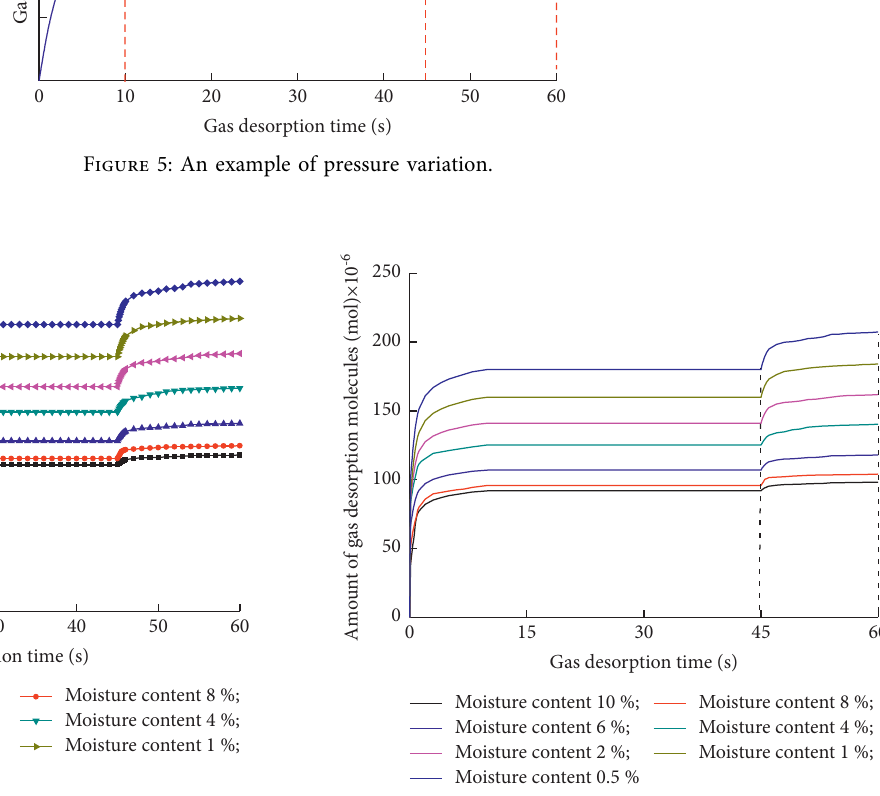
Figure 6: Methane desorption pressure curves of coal samples. Figure